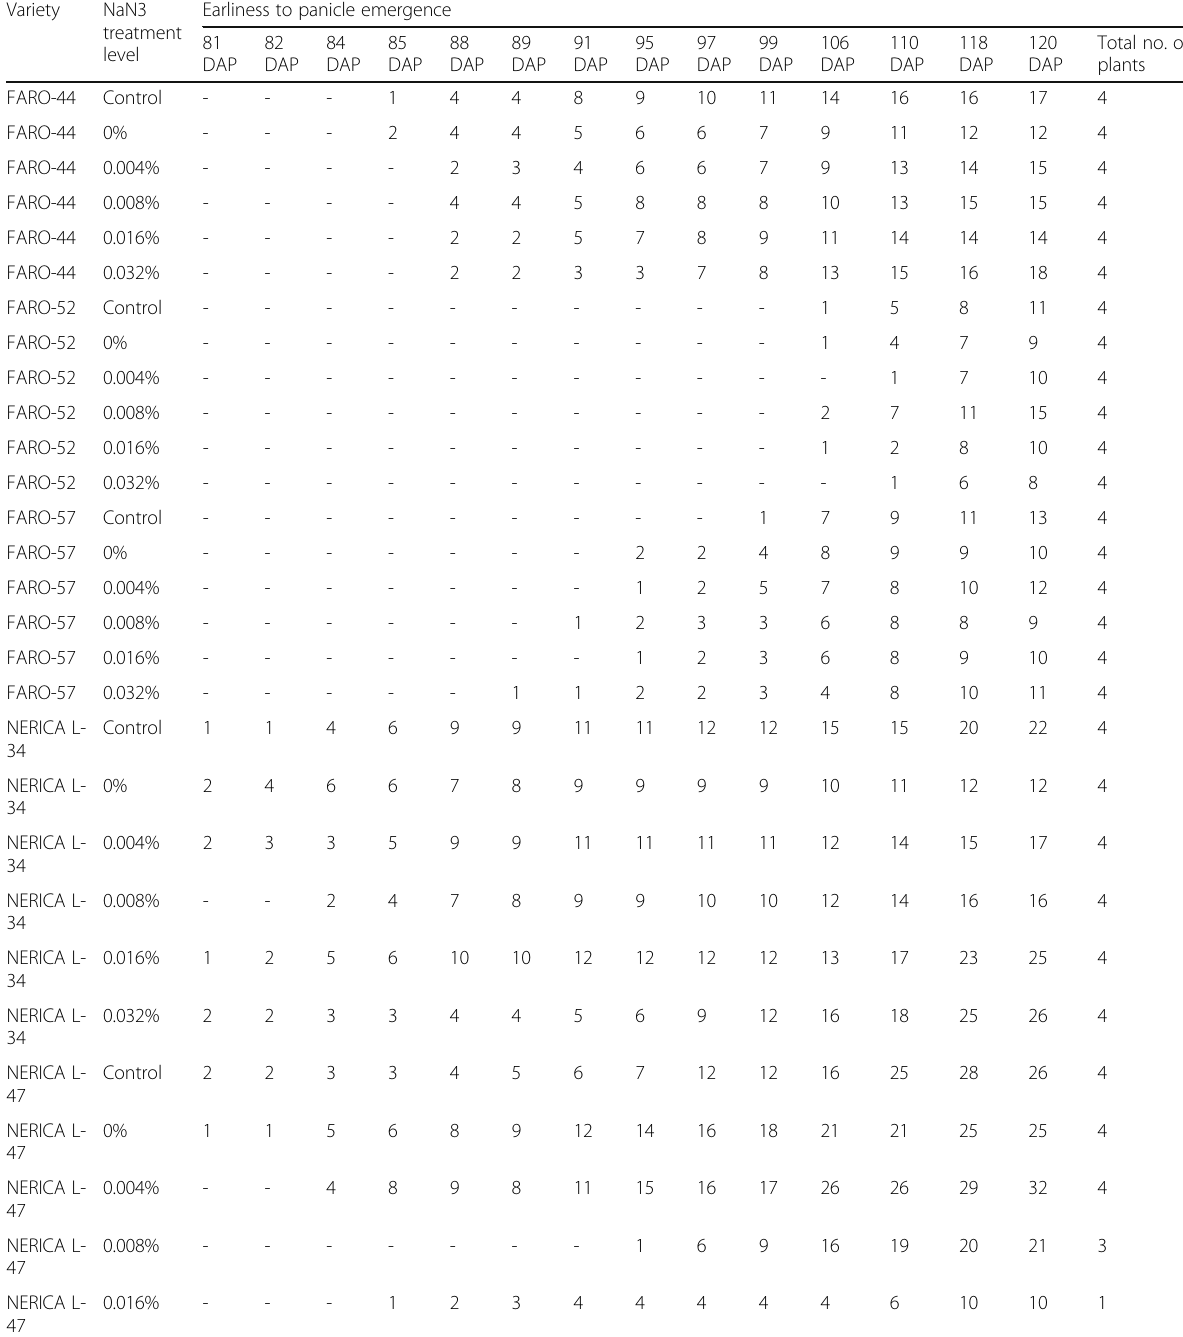
Table 5 Number of days to flowering and panicle emergence in the five rice varieties